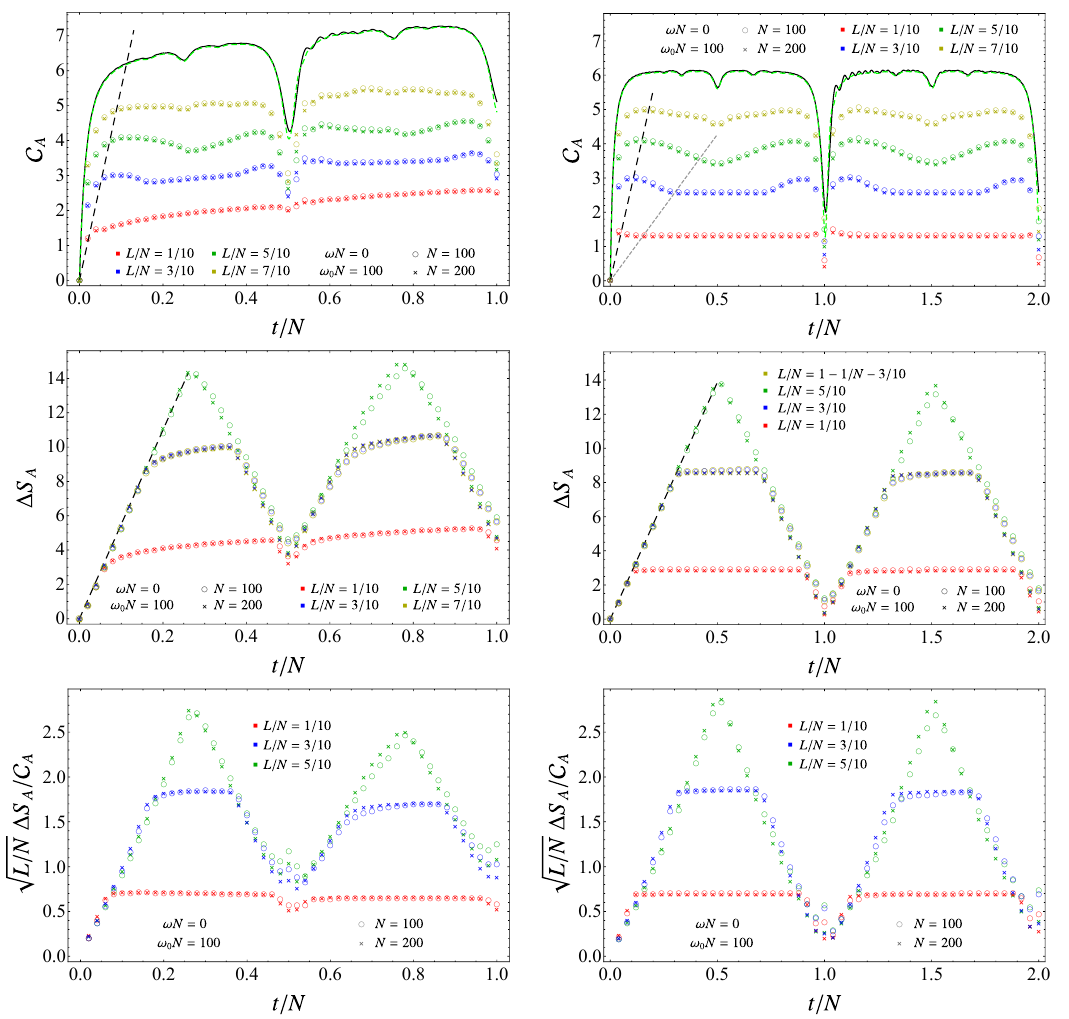
Figure 7 . Temporal evolution of C A in (4.6) (top panels), of ∆ S A in (4.7) (middle panels) and of p L/N ∆ S A / C A (bottom panels) after the global quench with gapless evolution Hamiltonian and ω 0 N = 100 , for a block A made by L consecutive sites in a harmonic chains with either PBC (left panels) or DBC (right panels) made by N sites (in the latter case A is adjacent to a boundary). When L = N the complexity (3.7) is shown for N = 100 (solid black lines) and N = 200 (dashed green